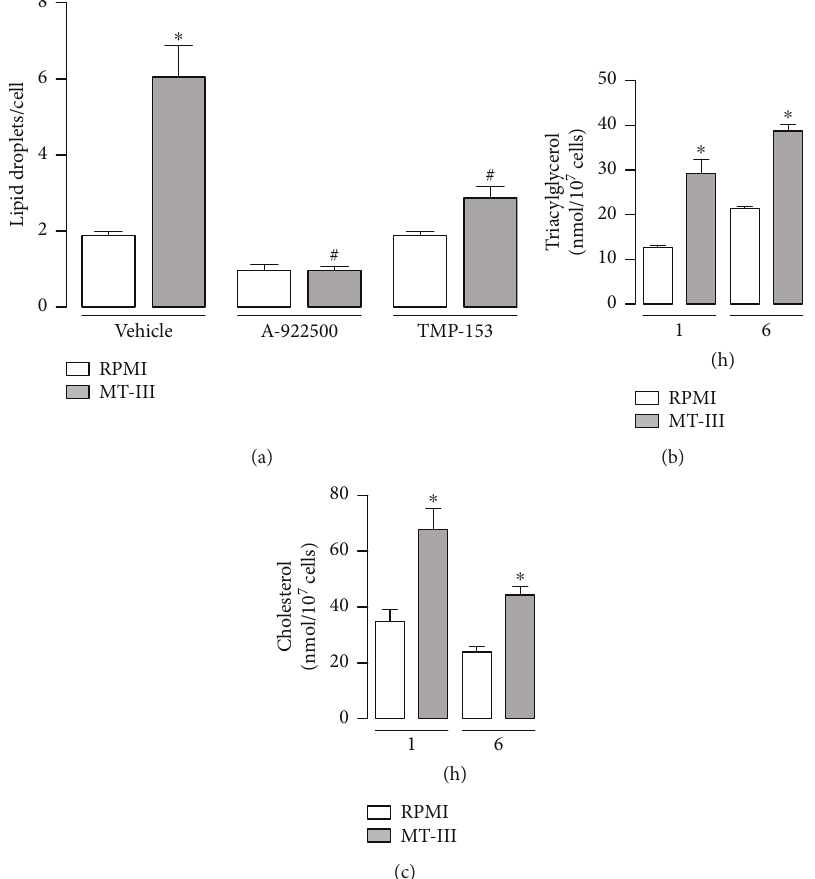
Figure 5: DGAT and ACAT enzymes are essential for LD formation induced by MT-III in macrophages. (a) Peritoneal macrophages were incubated with A922500 (100nM), a DGAT inhibitor or TMP-153 (100nM), an ACAT inhibitor or vehicle ( < 1% DMSO/RPMI) for 1h and then with MT-III (0.4 μ M) for 12 h. LDs were quanti fi ed using light microscopy after osmium staining. Each bar represents the mean ± SEM LDs/cell in 50 counted cells. ∗ p < 0 05 compared with control group; # p < 0 05 compared with vehicle-treated MT-III-stimulated cells. Levels of (b) TAG and (c) CE in 1.10 7 macrophages extracts incubated with MT-III (0.4 μ M) or RPMI (control) for 1 and 6 h quanti fi ed by speci fi c detection kits. Values represent means ± SEM from 3 – 5 animals. ∗ p < 0 05 compared with the control